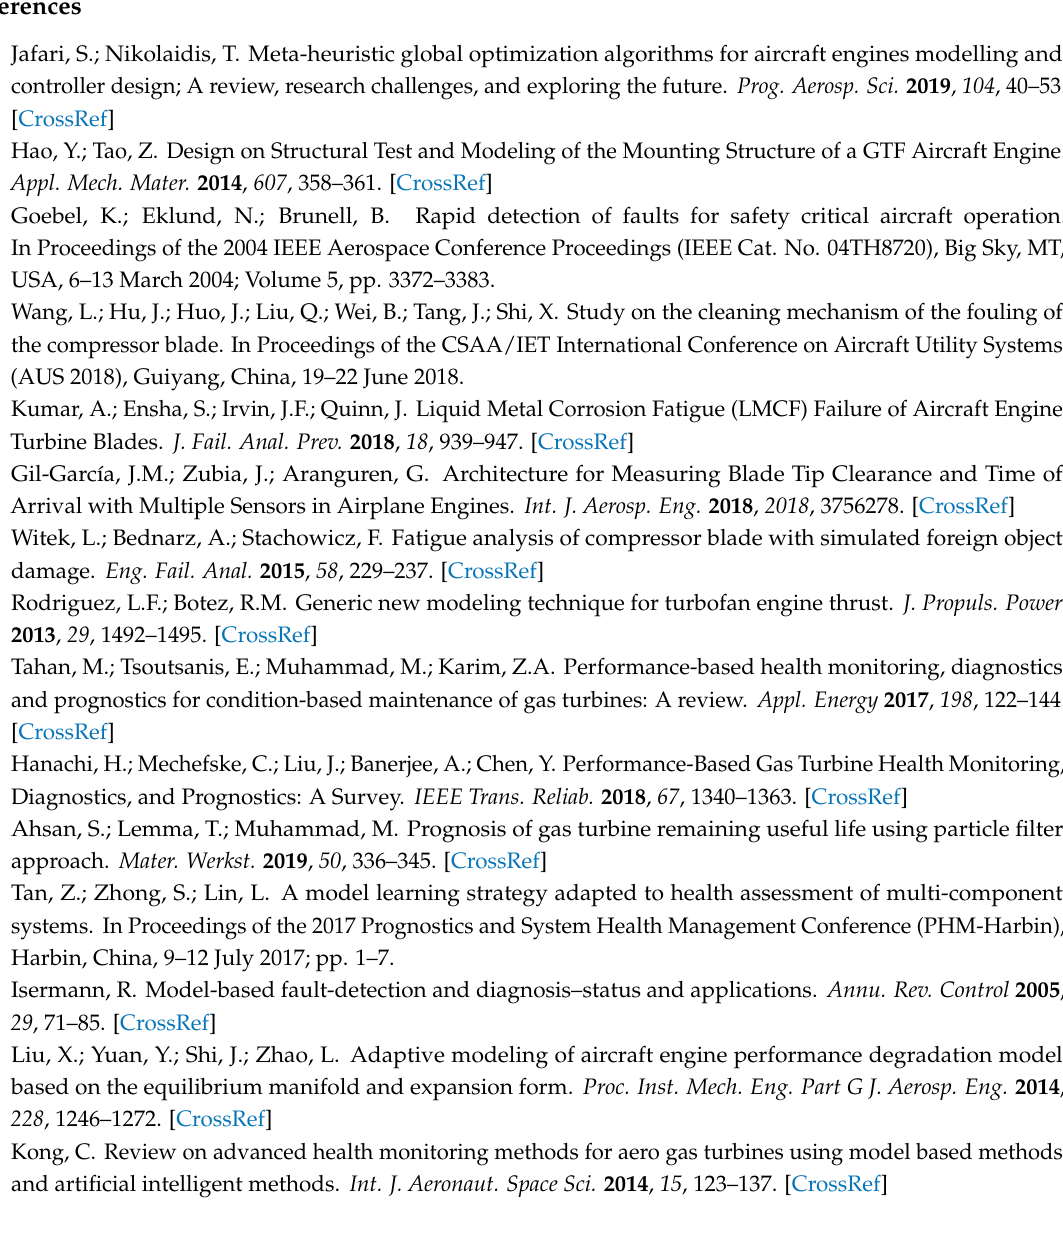
algorithm can generate more compact network structure and higher learning speed for both regression problems and classified problems. Experiment results in estimating gradual component performance degradation and recognizing abrupt failure patterns show that DKELMs can effectively reduce training time and testing time while maintaining similar or even generating higher network accuracy